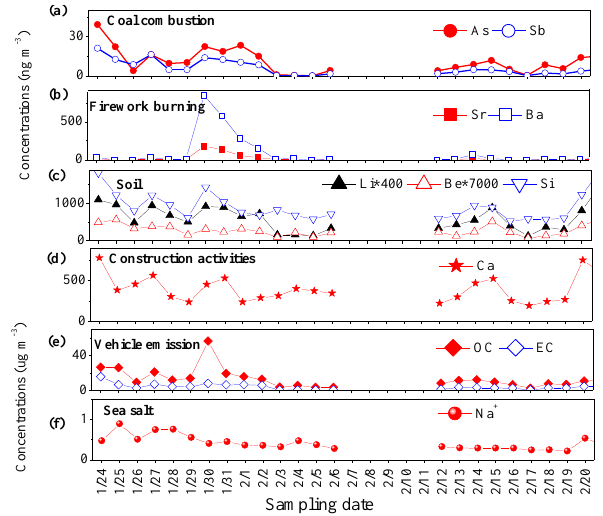
Figure 10. Time series of tracers for (a) coal combustion, (b) firework burning, (c) soil, (d) construction activities or road dust, (e) vehicle emission and (f) sea salt. The y axis units for (a) , (b) , (c) and (d) arengm − 3 and are ug m − 3 for (e) and (f) . 30 January–7 February belongs to the Chinese Spring Festival in 2014; 30 January